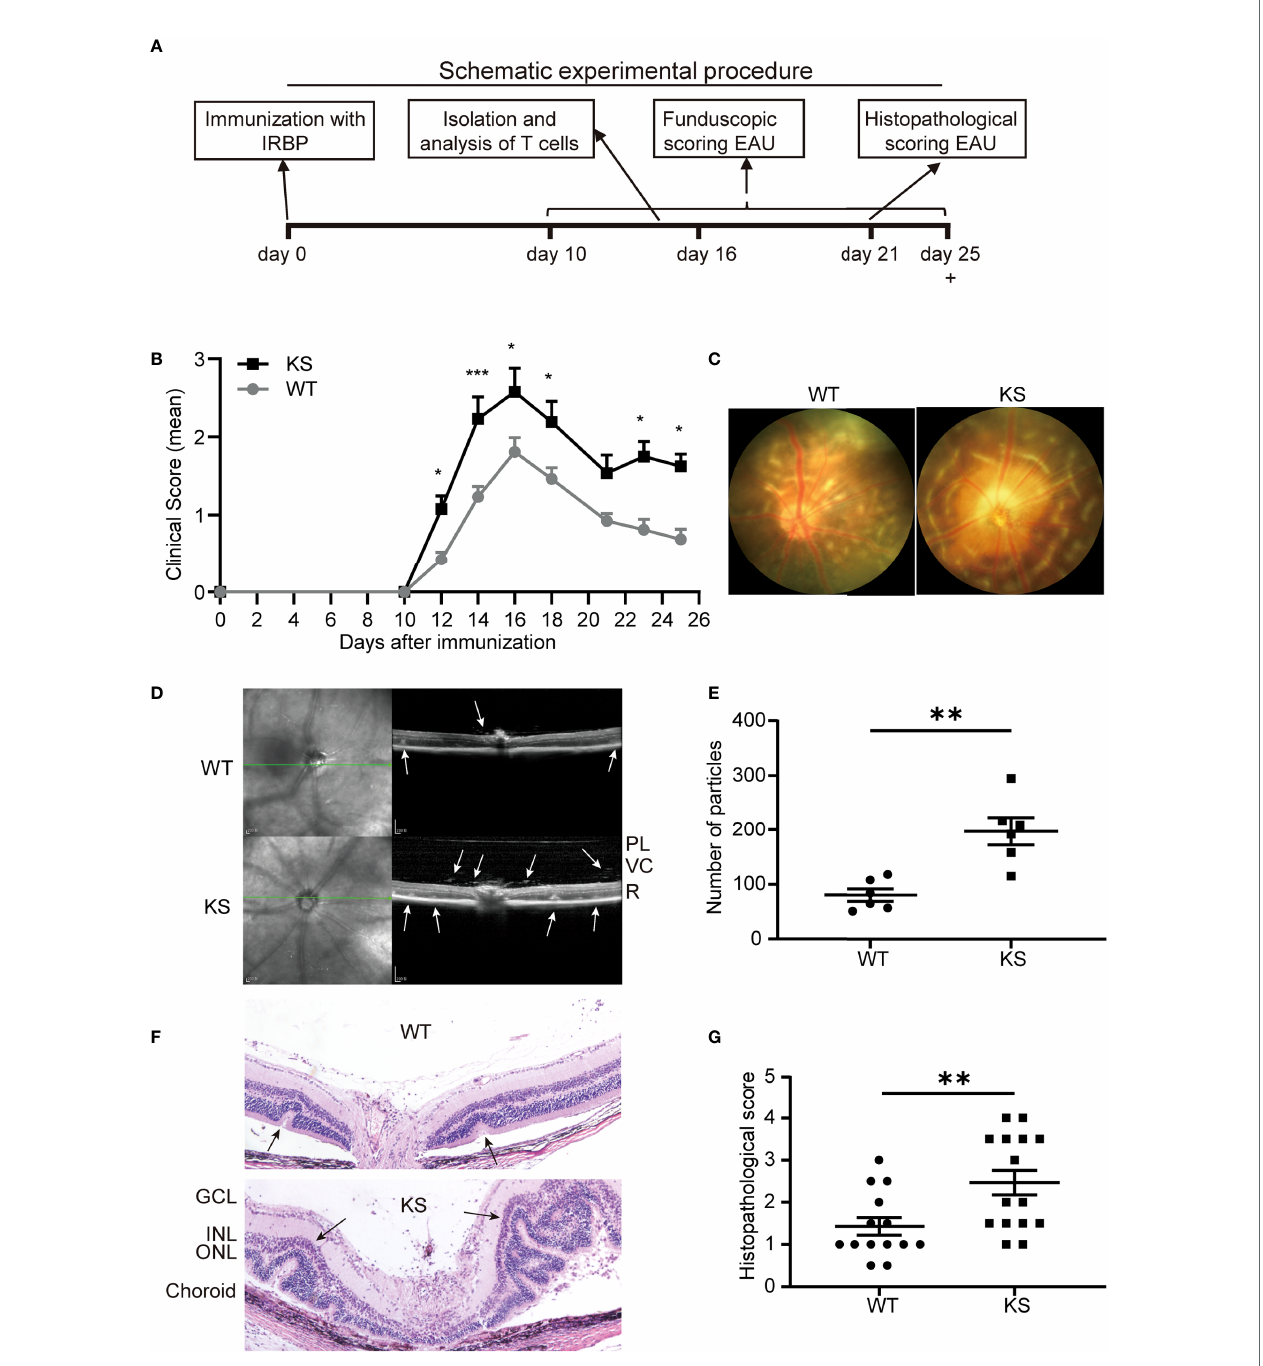
FIGURE 2 | Kallistatin-transgenic (KS) mice develop exacerbated EAU. (A) A schematic experimental procedure of EAU induction and examination. (B) EAU clinical score of WT and KS mice (n = 13 in each group). Age- and sex-matched WT and KS mice were immunized with hIRBP 651-670 , and their eyes were examined by indirect ophthalmoscope and the clinical score was recorded from day 10 to day 25. Data are shown as mean ± SEM. *p < 0.05, **p < 0.01, ***P < 0.001, two-way ANOVA. (C) Representative images of the eyes in WT and KS mice on day 16 after EAU induction by retinal imaging microscope. (D) Representative images showing fundus condition by SD-OCT. Hyper-re fl ective foci in the vitreous cavity and retinal folds (white arrows) were observed around the optical nerve. PL, posterior lens margin; VC, vitreous cavity; R, retina. (E) Particles in the SD-OCT images were assessed and calculated using ImageJ. (F) Pathological representatives of hematoxylin and eosin (H&E) staining of the eye sections from WT and KS mice on day 21 after immunization. The retinal folds and protrusions near the optic disk were indicated by the black arrows. GCL, ganglion cell layer; INL, inner nuclear layer; ONL, outer nuclear layer. Original magni fi cation, 20X. (G) Histopathological scores for EAU in WT and KS mice at day 21 post immunization. Data are presented as the mean ± SEM. N = 6 (E) or > 6 (G) ; **p < 0.01, Mann-Whitney